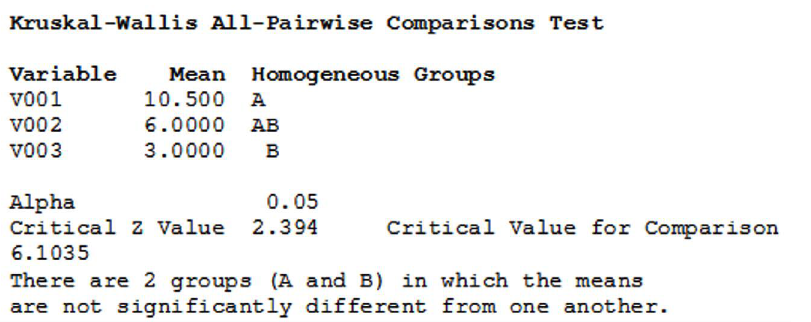
Fig. 2. Kruskal-Wallis All-Pairwise Comparisons Test of Lactobacillus acidophilus ATCC ® 4356 concentrations against Propionibacterium acnes ATCC® 11827.